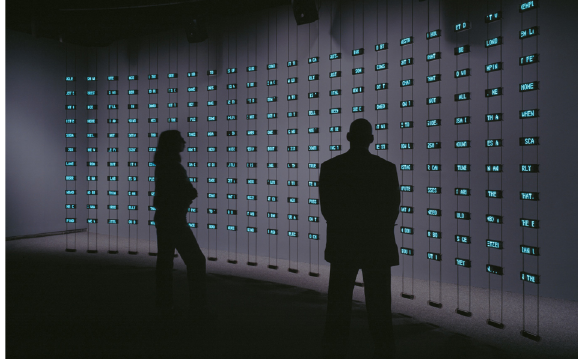
Figure 3 | Listening Post, Rubin & Hansen,